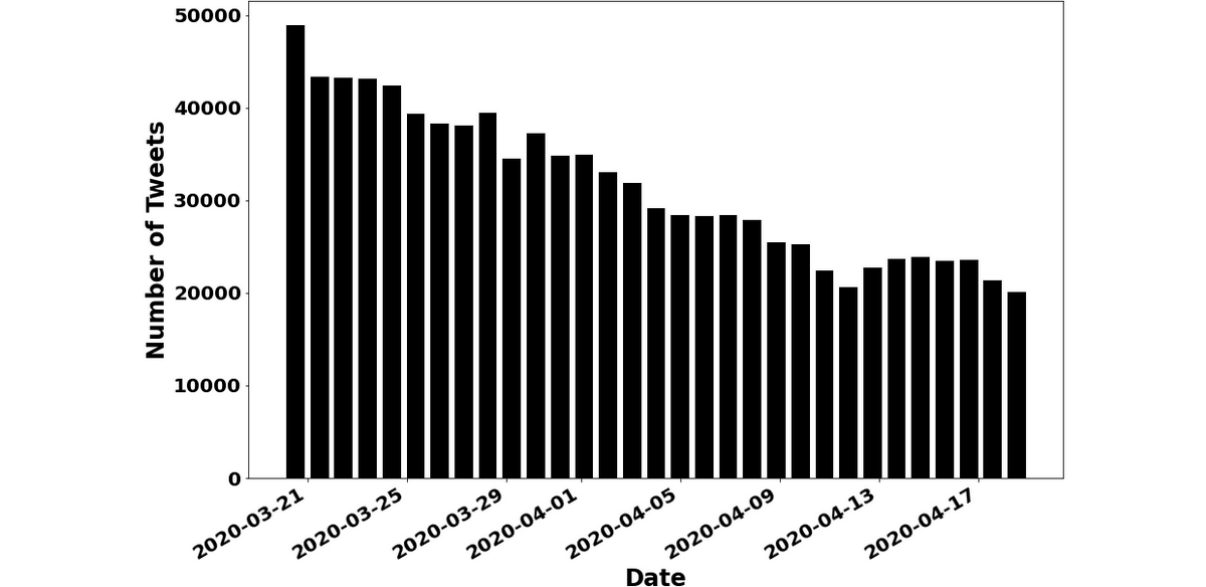
Figure 1. Number of tweets related to coronavirus disease (COVID-19) from March 20, 2020, to April 19,